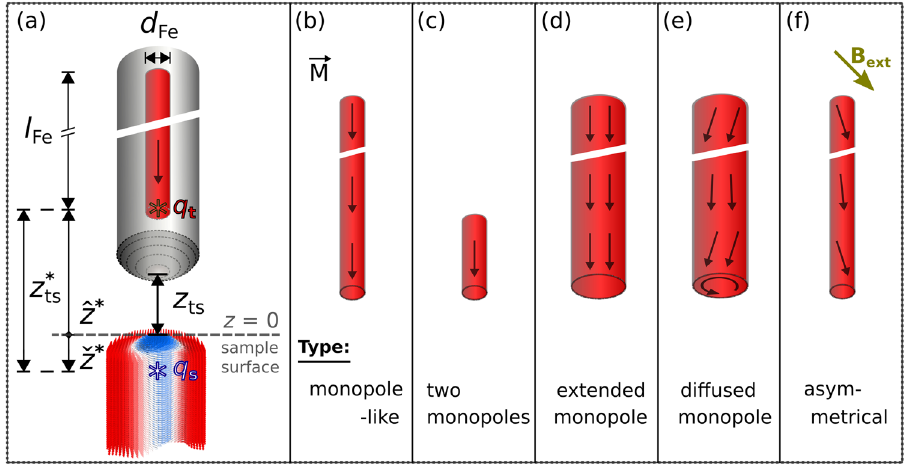
Fig. 2 Sketch of nanowire probes. a Iron nanowire probe (upper part, in red, d Fe and l Fe referring to the iron nanowire ’ s diameter and length, respectively) contained in a protecting carbon nanotube (in grey); the lower part shows a magnetic sample (sample surface at z ¼ 0) containing a bubble-like magnetic single-domain con fi guration (in blue), which is embedded in an oppositely magnetized environment (red). q s indicates the upper magnetic pole associated with the magnetic charge of the bubble base. b – f indicate several types of nanowire (NW) geometries and magnetization con fi gurations. b The end of an ideal in fi nitely long and in fi nitely thin nanowire probe generates a stray- fi eld resembling the fi eld of a point monopole q t . Deviations from point monopole behaviour can be caused by: ( c ) fi nite NW length, ( d ) non-zero NW diameter, ( e ) non-homogeneous internal magnetization, and ( f ) a NW magnetization direction that deviates from the long (easy)